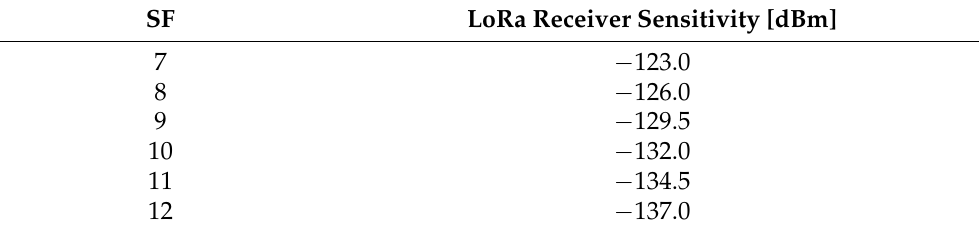
Table 3. Receiver sens. at BW = 125